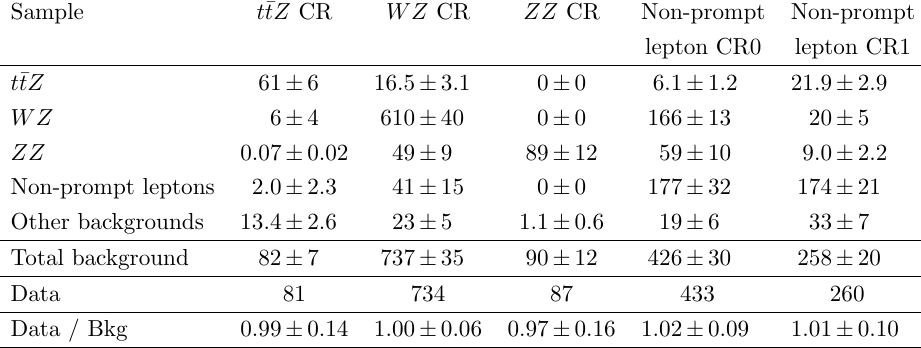
Table 9 . Event yields in the background control regions for all signi(cid:12)cant sources of events after the combined (cid:12)t under the background-only hypothesis. The uncertainties shown include all of the systematic uncertainties described in section 7. The entry labelled \other backgrounds" includes all remaining backgrounds described in section 3 and in table 2. The uncertainties in the post-(cid:12)t yields are calculated using the full correlation matrix from the (cid:12)t.